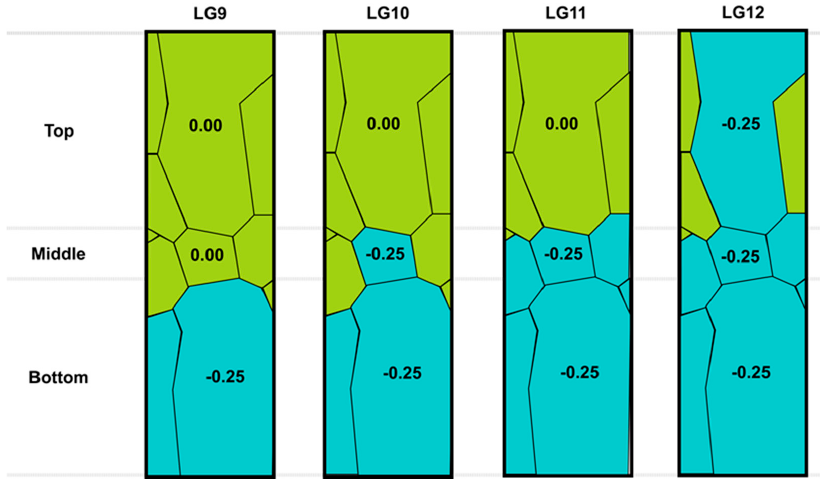
Figure 12. The grain orientations of the four considered cases (LG9 to LG12).